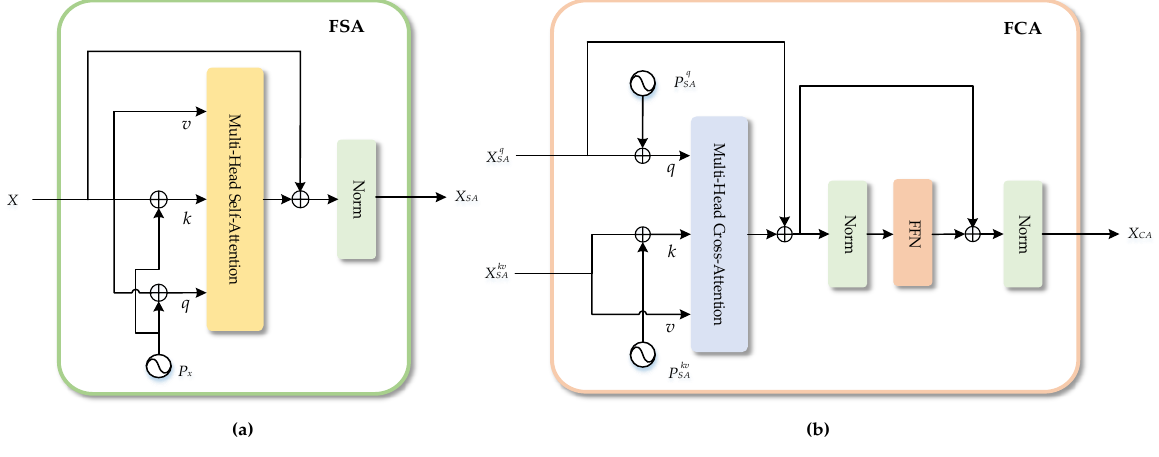
Figure 6. The structure of TIT. ( a ) shows the FSA structure, and ( b ) displays the FCA structure. From Figure 6a, the FSA module has one input and one output. In the FSA module, the features are enhanced using the multiheaded self-attention with the residual form.